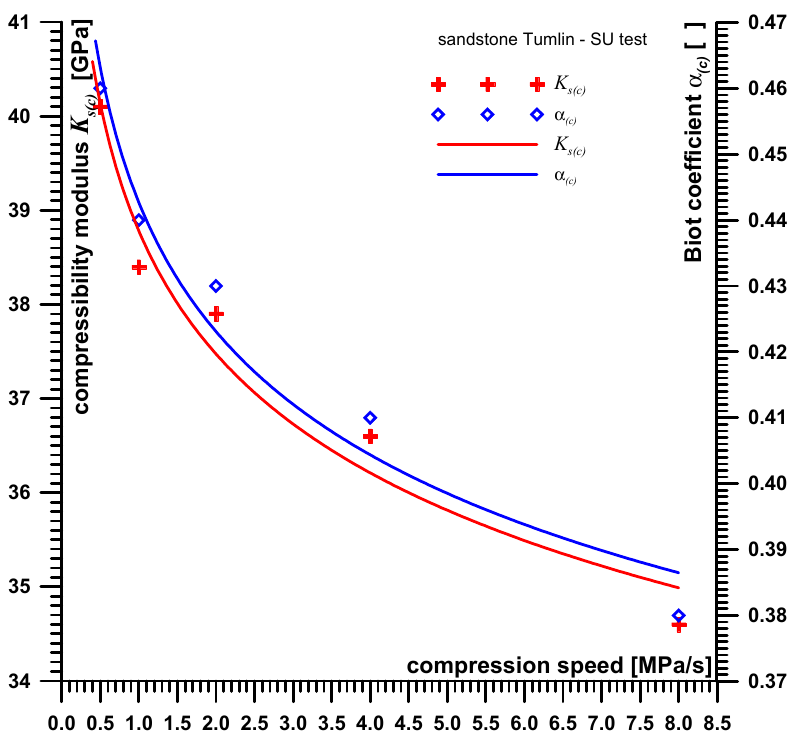
Figure 10. Relationship between the values of the α coefficient and K s modulus and the compression rate—SU test; Tumlin sandstone.